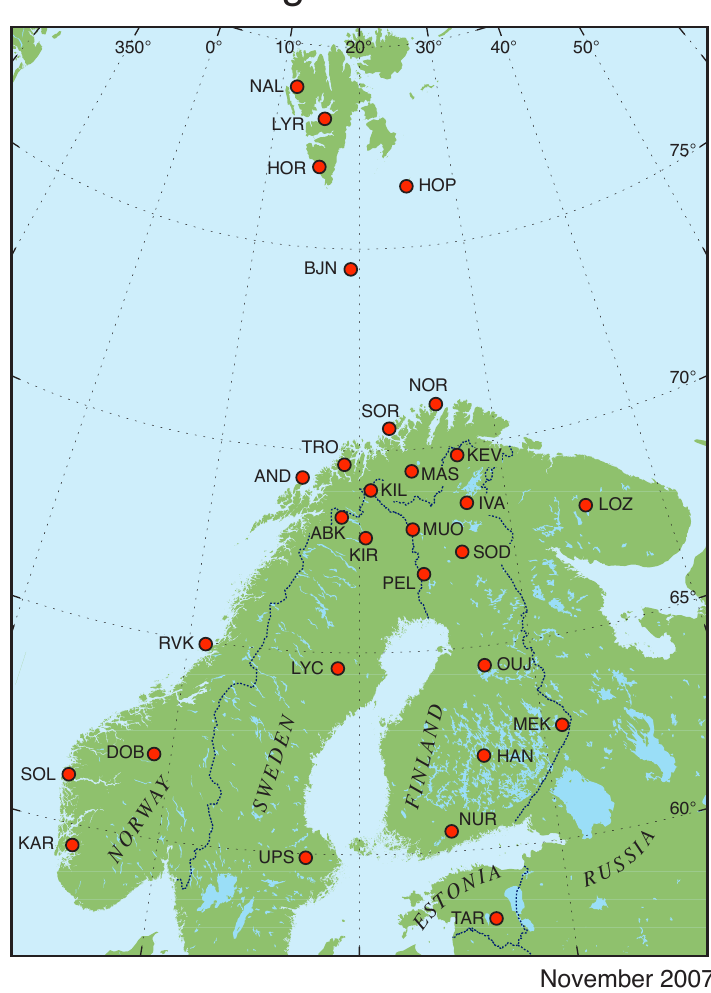
Fig. 1. The present extent of the IMAGE magnetometer network (see also http://space.fmi.fi/image/). During the omega-band event on 9 March 1999 data from TAR, DOB, RVK, LEK, IVA and MAS was not available. level, leading to negative CNA values. These time-steps are omitted from the analysis. The emap estimate is given in a 10 × 10 km grid, but the true spatial resolution of the estimate is variable, mainly due to the IRIS CNA measurements. IRIS has about 18 km resolution near the zenith over Kilpisj¨arvi, but the resolution decreases with increasing distance from the zenith. The DASI optical data are stored at 10 km resolution, and in the energy-map calculations the CNA measurements are interpolated onto the same 10 km